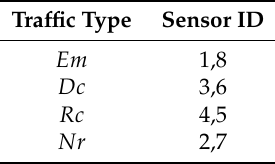
Figure 12. Simulation topology: A 5 × 5 grid where grid with number represents the sensor ID. Table 2. Traffic